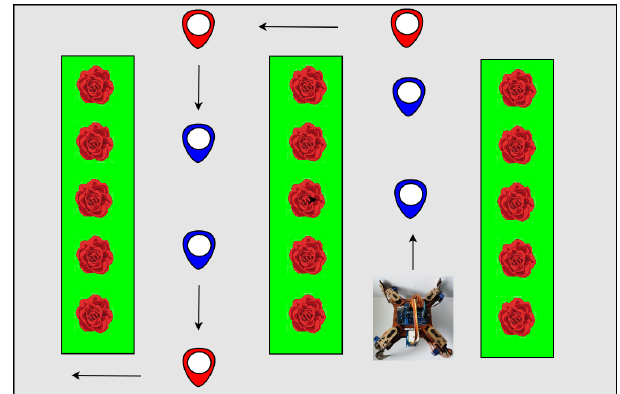
Figure 4. Vehicle movements inside to greenhouses, marks: red, sub-marks: blue.